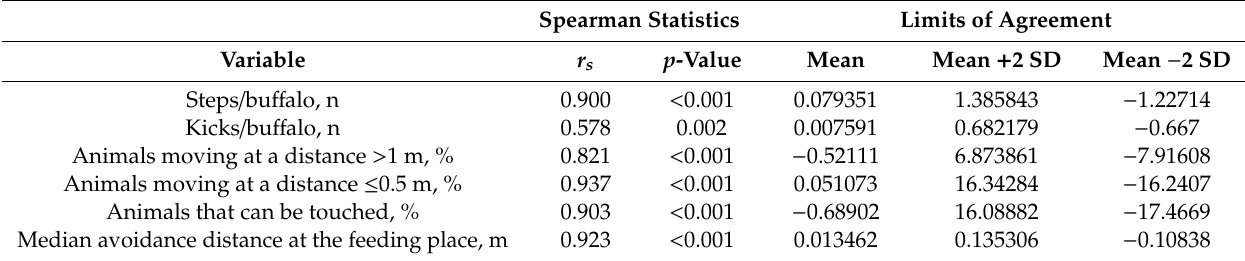
Table 2. Test–retest reliability of the variables observed on the animals using the Spearman rank correlation coe ffi cient ( r s ) and limits of agreement (mean of di ff erences ± 2 SD). Calculations were based on two farm visits (n =